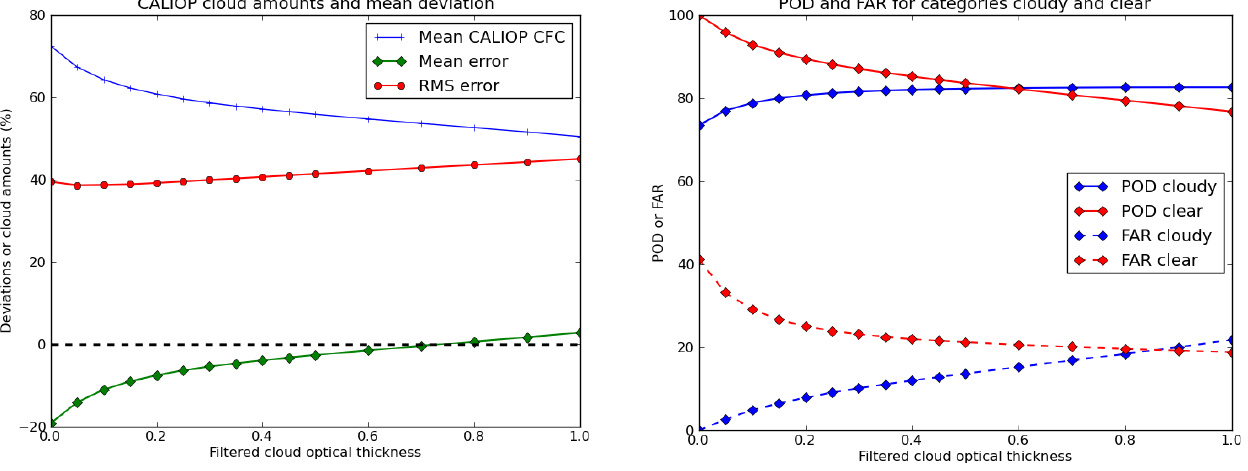
Fig. 8. Same as Fig. 5 but after treating CLARA-A1/PPS misclassi- fied clear pixels as truly clear and not as cloudy (see motivation in